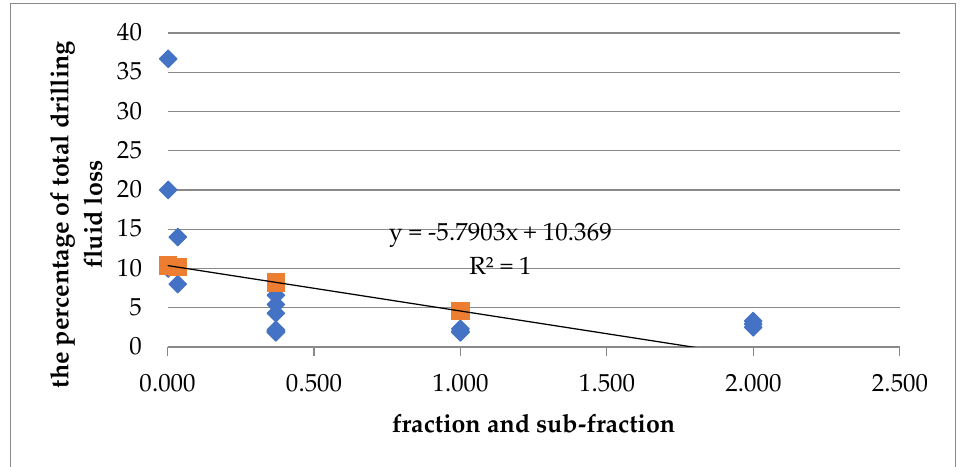
Figure 10. Correlation between the percentage of the total drilling fluid loss and the type of soil fraction in the Pęciszów facility.